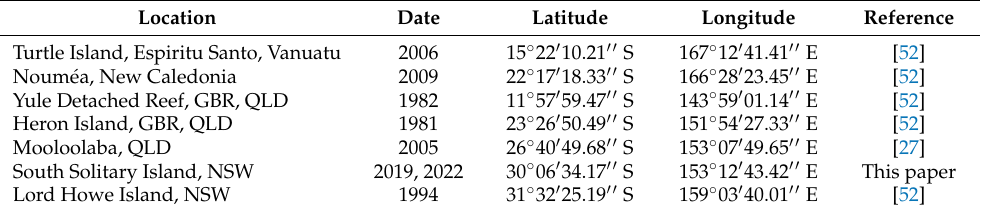
Table 6. Selected distribution records of Goniobranchus rufomaculatus from Oceania.